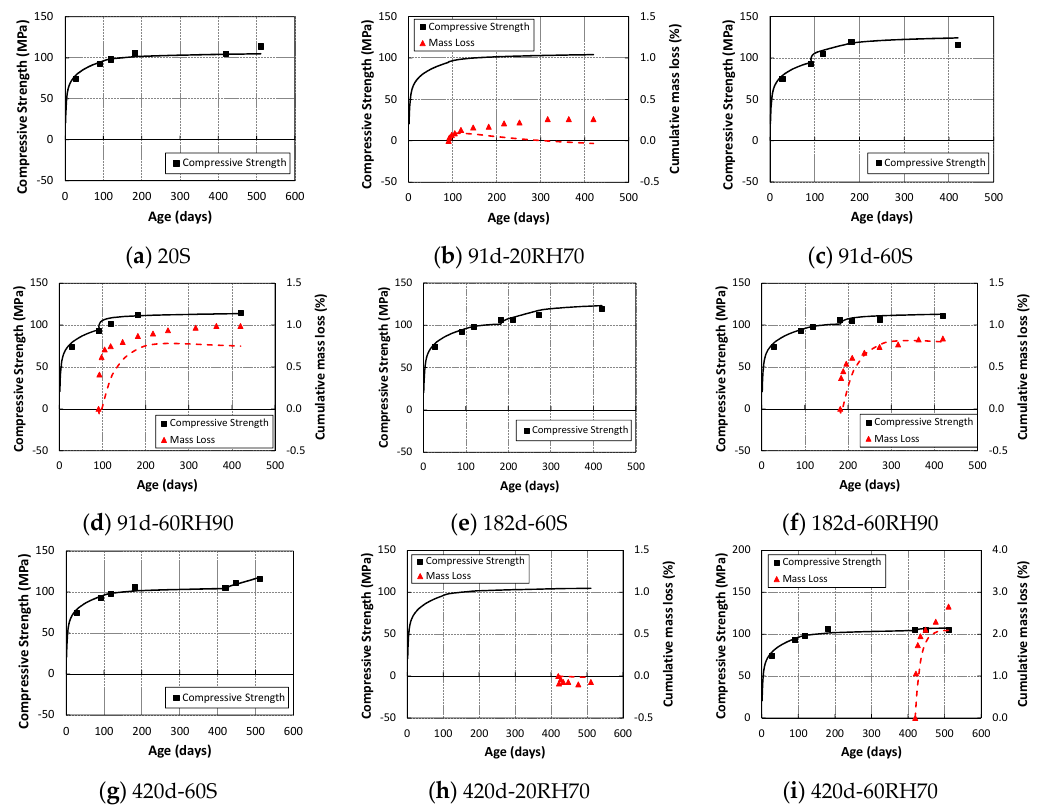
Figure 23. Comparison of compressive strength and weight loss based on the extensive model (W/C = 30%) [27]. (Dot: experiment, Solid/chain line: analysis).